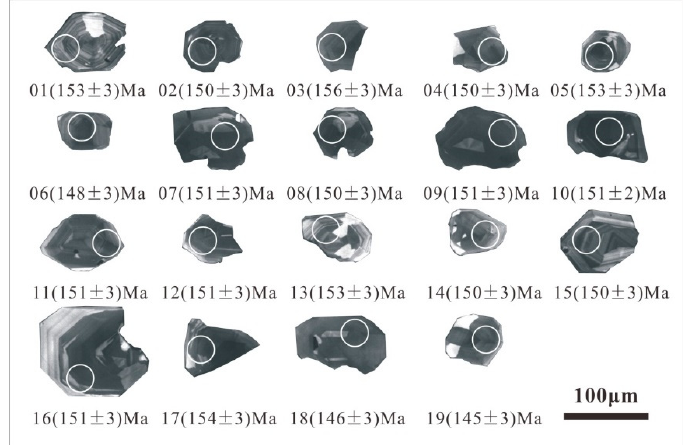
Figure 8. Zircon CL image of andesitic clastic lithic tuff in the host rock of the Qiyimuchang lead–zinc deposit. Table 4. LA-ICP-MS zircon U-Th-Pb dating results of the andesite tuff from Qiyimuchang deposit.